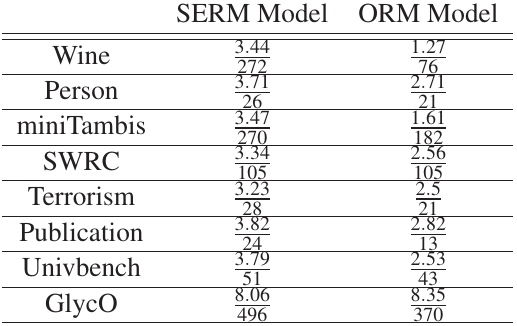
Table 1. Comparison of ORM and SERM